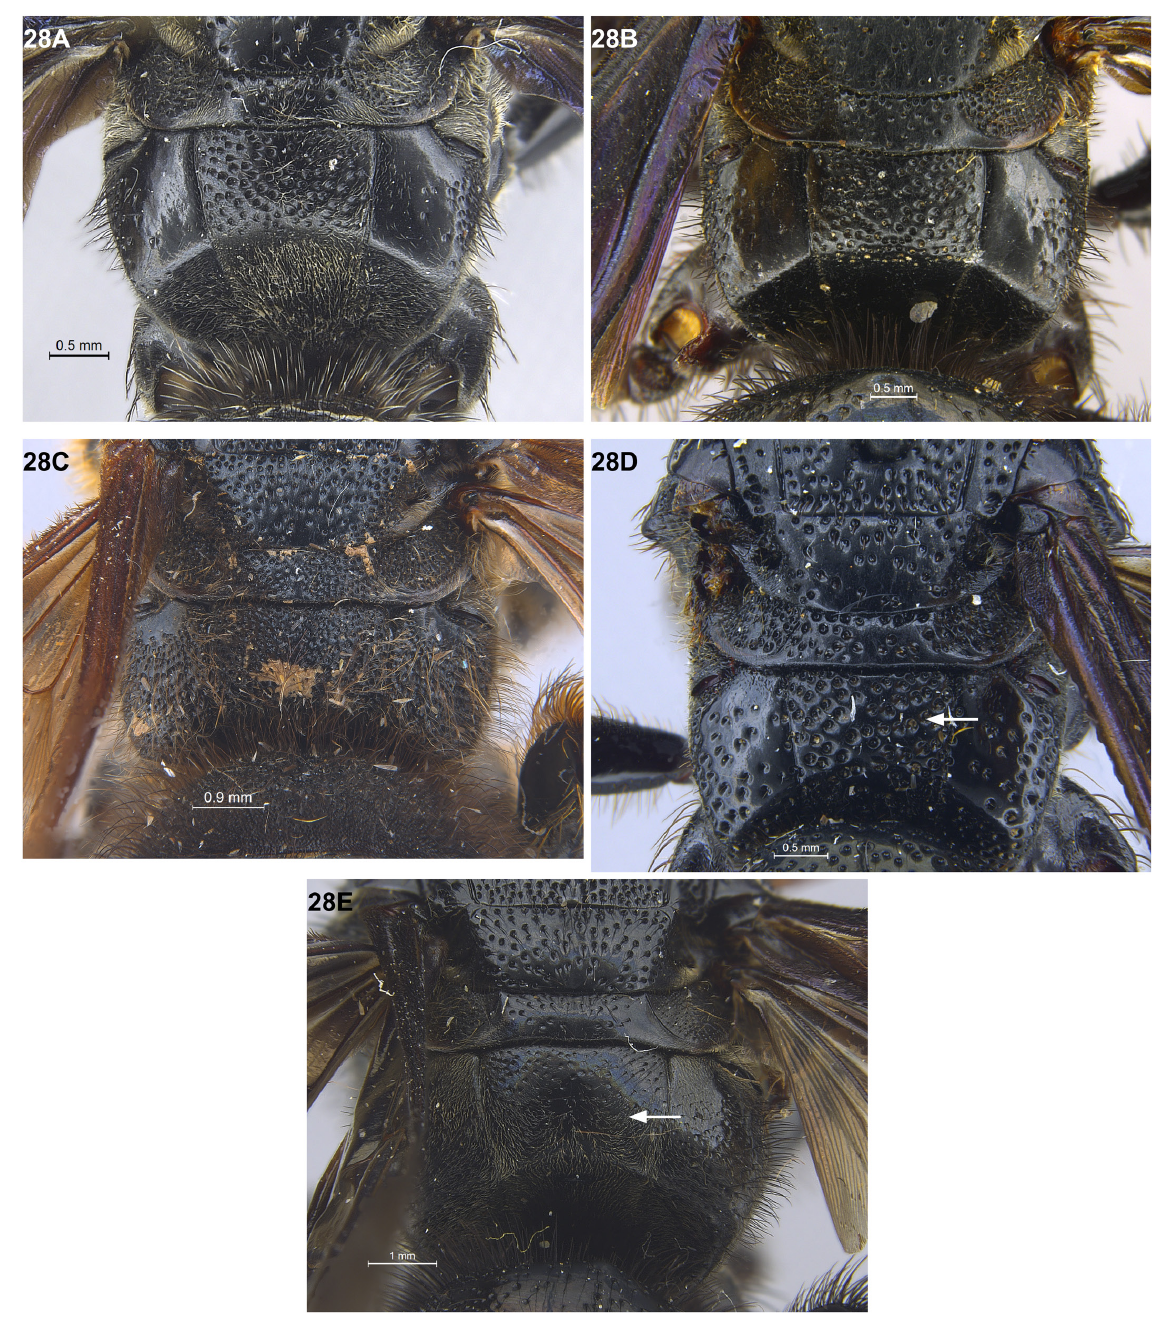
Fig. 28. Females, propodeum. A . Scolia binotata Fabricius, 1804 . B . Sc. binotata orange